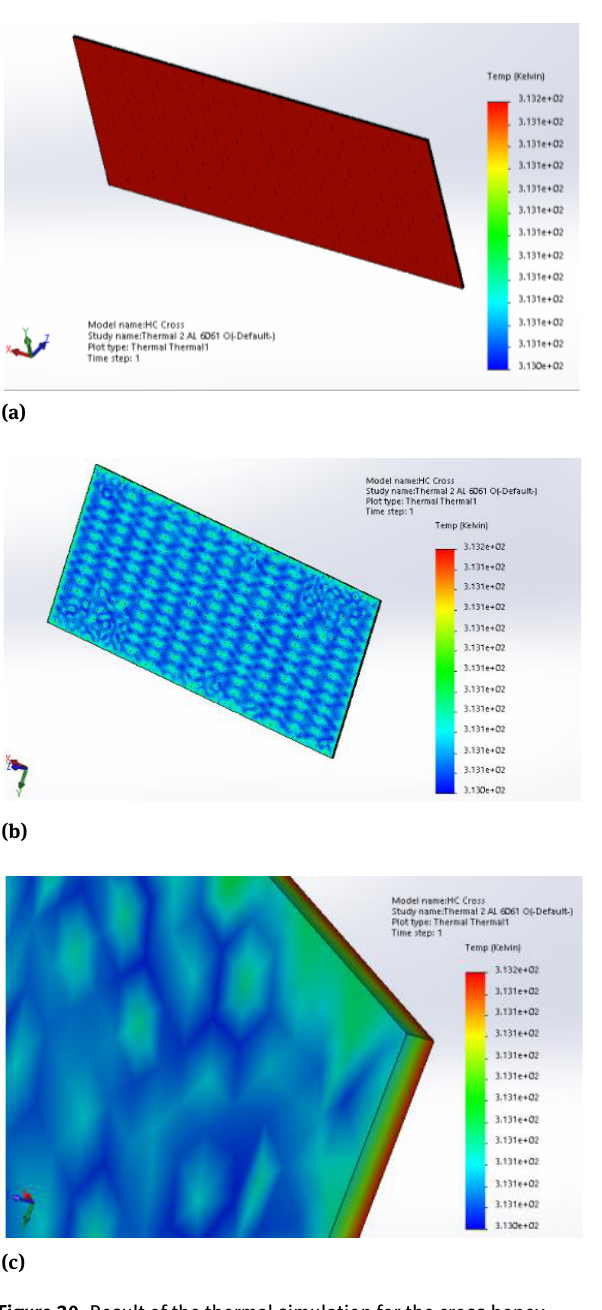
Figure 21: Result of the thermal simulation for the square honey- comb: (a) outer surface, (b) inner surface, (c)